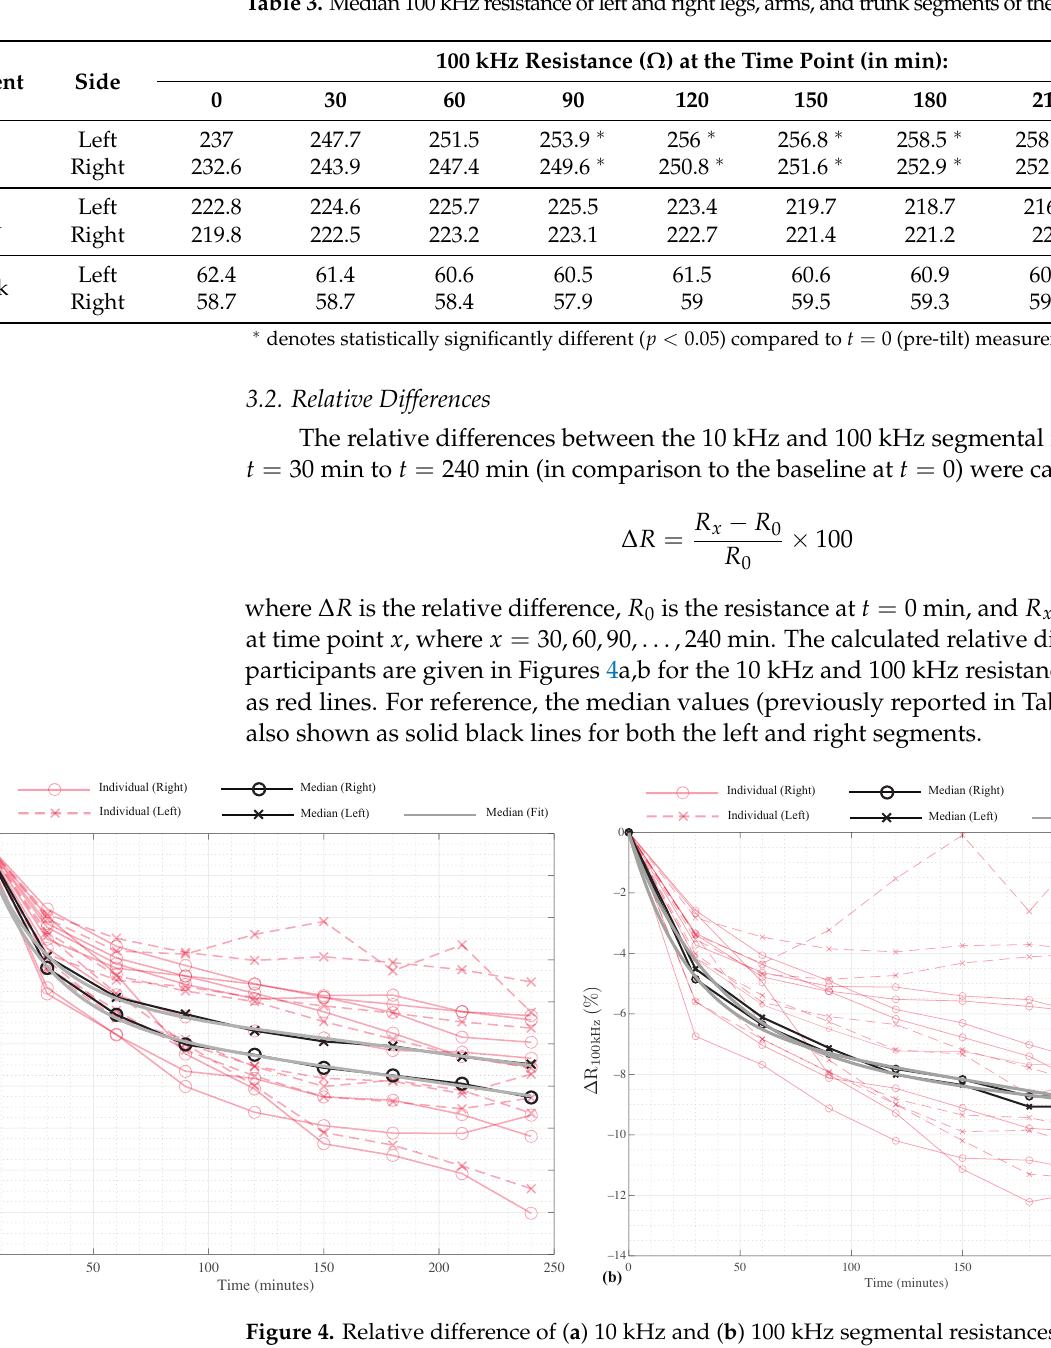
Figure 4. Relative difference of ( a ) 10 kHz and ( b ) 100 kHz segmental resistances from left (x) and right (o) legs of study participants over 240 min of HDT with median (black) and fit (gray) values. The median resistances show a decreasing rate of change with increasing time in the HDT position. This implies that there are potentially two-decay modes (e.g., different mechanisms governing the rates of change). To model this behavior, the median datasets were fit to the two-term exponential function given